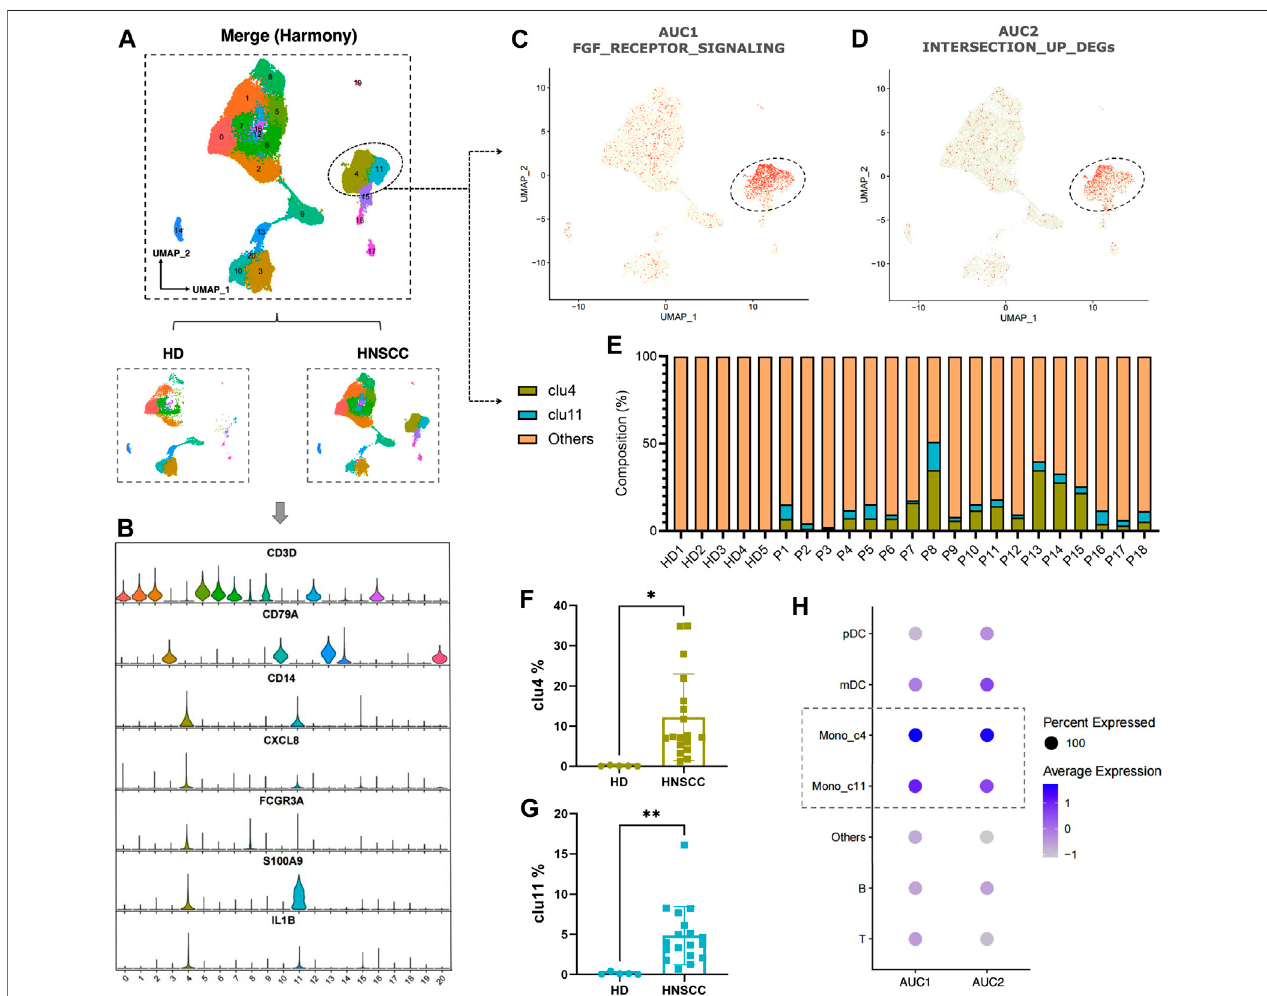
FIGURE 9 | (A) Twenty cell clusters were successfully classi fi ed by t-SNE algorithm. (B) Expression of several cell surface and intracellular markers in each cell subpopulation. (C,D) Individual cell AUC score overlay for FGF receptor signaling and highly expressed DEGs in low-survival patients (cells from n = 18 HNSCC, n = 5 HD). (E) Compositionofclusters4and11ineachsample. (F) Comparisonofcluster4betweenHNSCCandHD. (G) Comparisonofcluster11betweenHNSCCandHD. (H) Dot plot heatmap showing AUC1 and AUC2 enriched in monocyte (clusters 4 and 11).